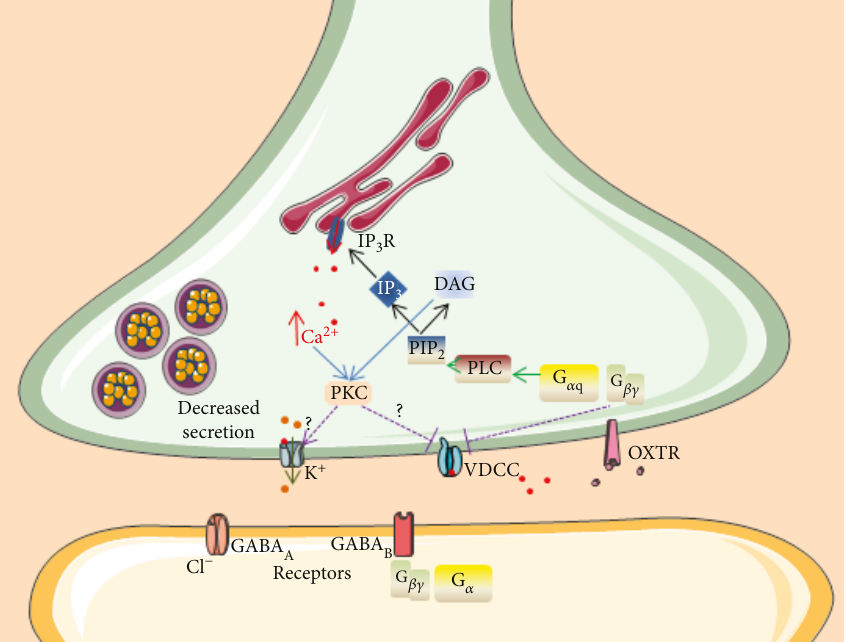
Figure 2: Presynaptic G protein-coupled oxytocin receptors modulate neurotransmitter release. OXTR: Oxytocin receptor; VDCC: voltage- dependent calcium channels; PIP : phosphatidylinositol biphosphate; IP : inositol 1,4,5-trisphosphate; DAG: diacylglycerol; GABA: 2 3 γ -aminobutyric acid